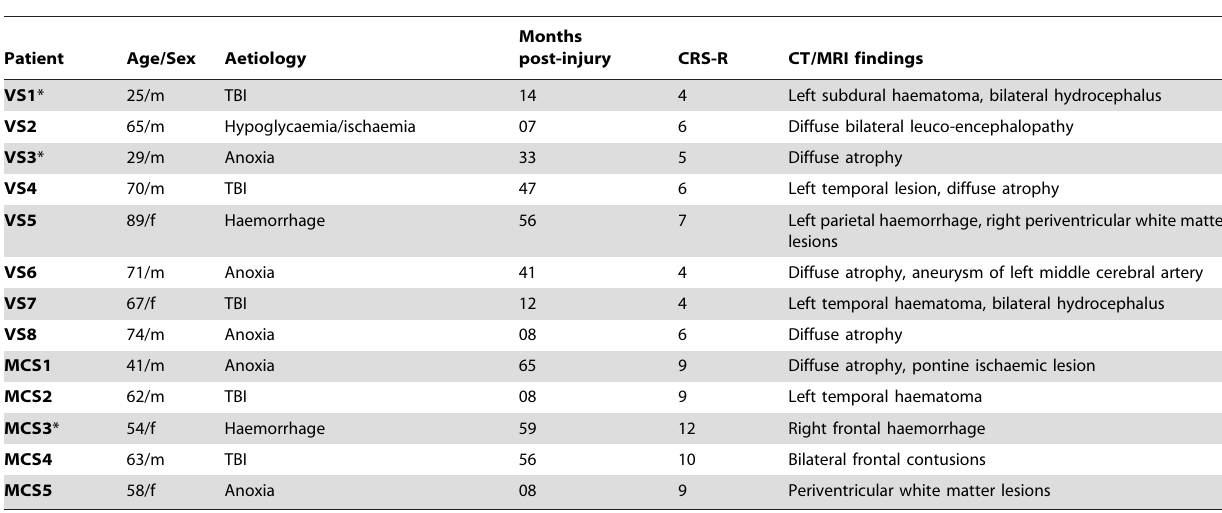
Table 1. Summary of demographic, clinical and neuroimaging data.